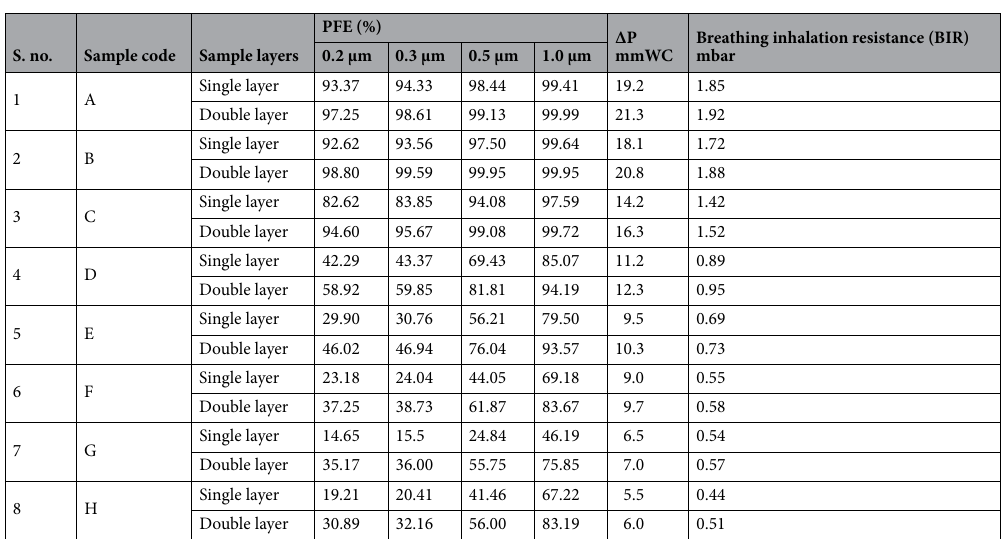
Table 3. Particulate filtration efficiency, ∆P and breathing inhalation resistance of PPE melt blown non woven samples.